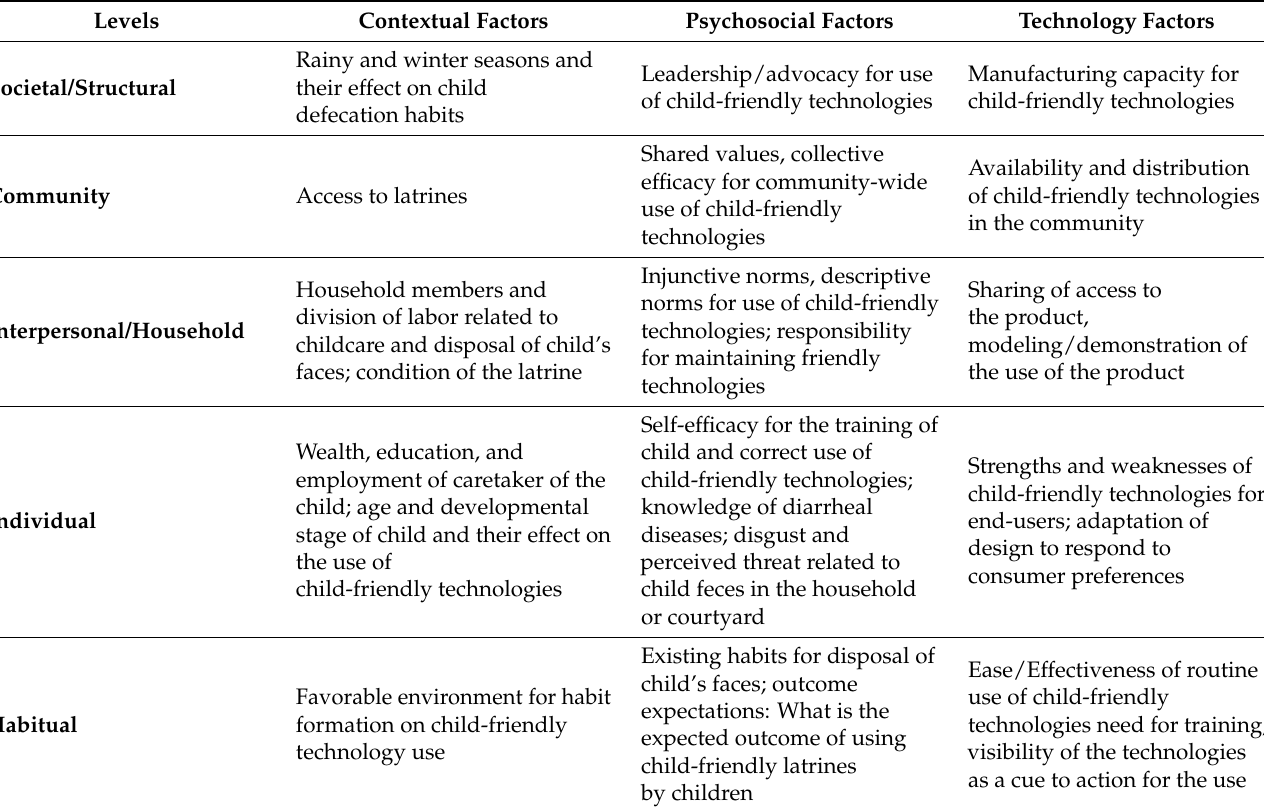
Table A2. The full IBM-WASH framework applied to the use of child-friendly